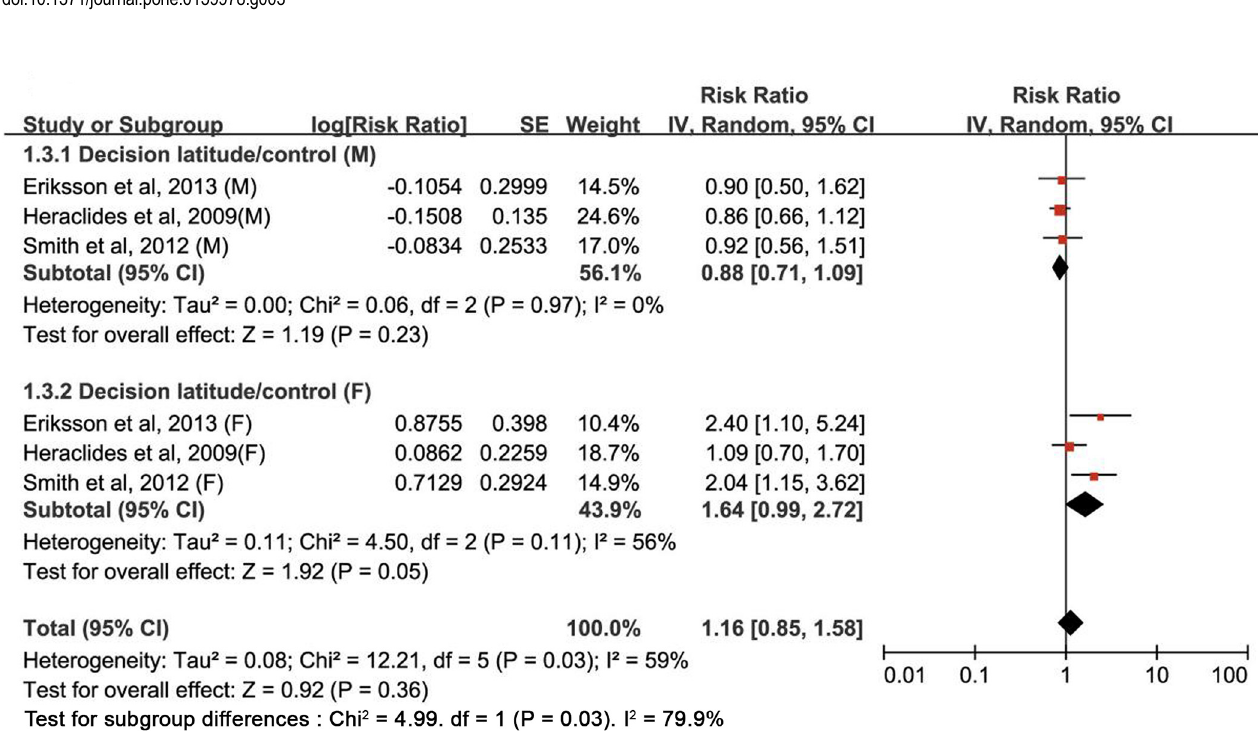
PLOS ONE | DOI:10.1371/journal.pone.0159978 August 11,